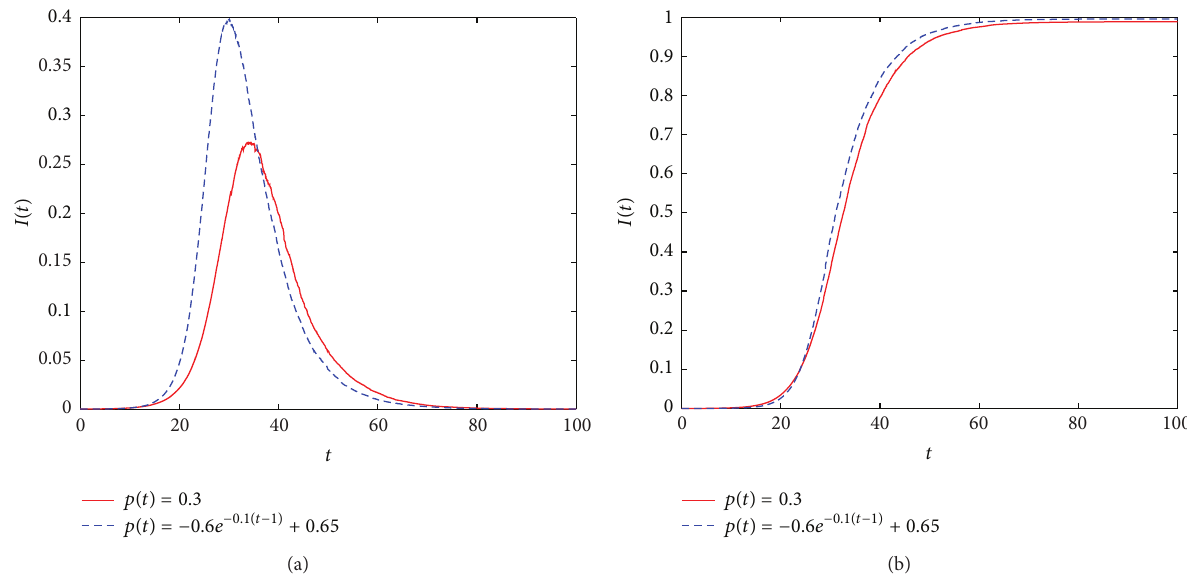
Figure11:DensityofspreadersandstiflersonSinaMicroblognetworkforthevaluesofthememoryrateisvariable (𝑝(𝑡) = −0.6𝑒 −0.1(𝑡−1) +0.65) and constant ( 𝑝(𝑡) = 0.3 ),